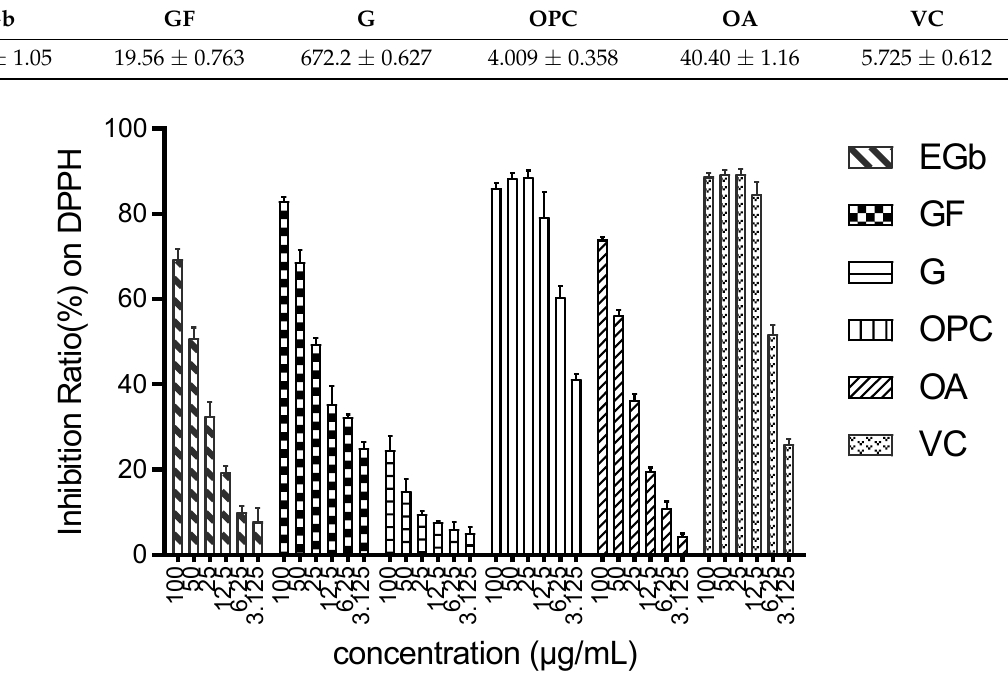
Figure 1. Scavenging effects of EGb functional components on DPPH free radicals.